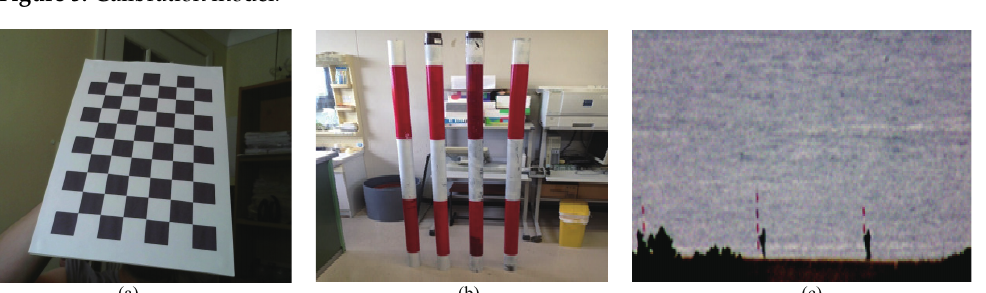
Figure 5. Calibration model.